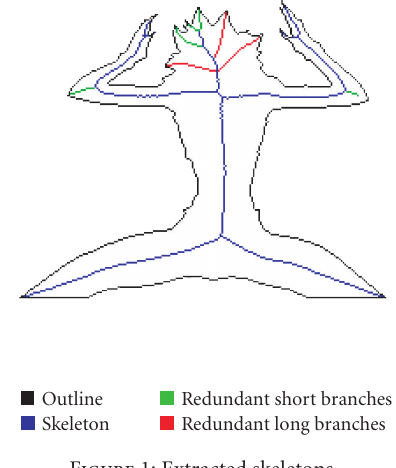
Figure 1: Extracted skeletons.